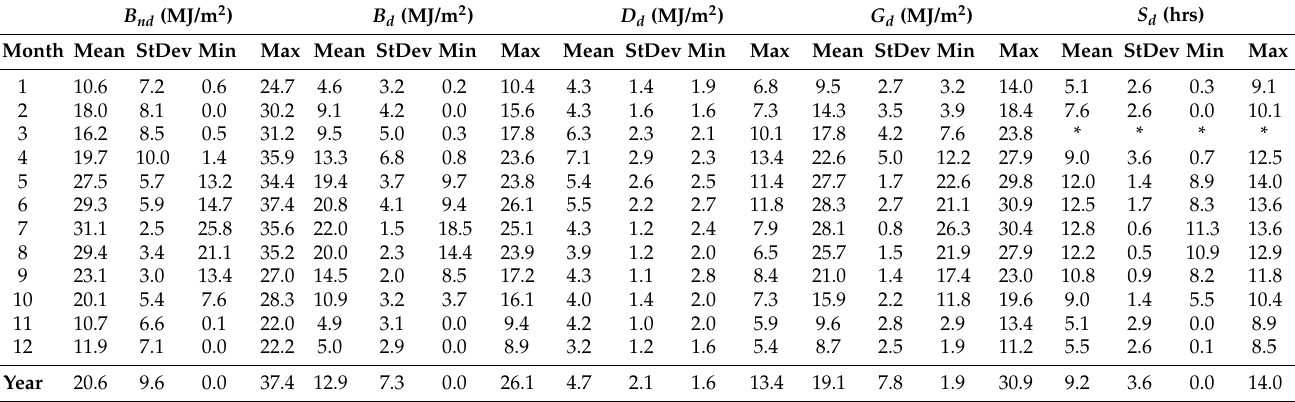
Table 8. Mean daily and extreme values and the standard deviations of the shortwave radiation components for each month of the year in MJ/m 2 . The last column shows the respective daily values of sunshine duration. Note: * means no